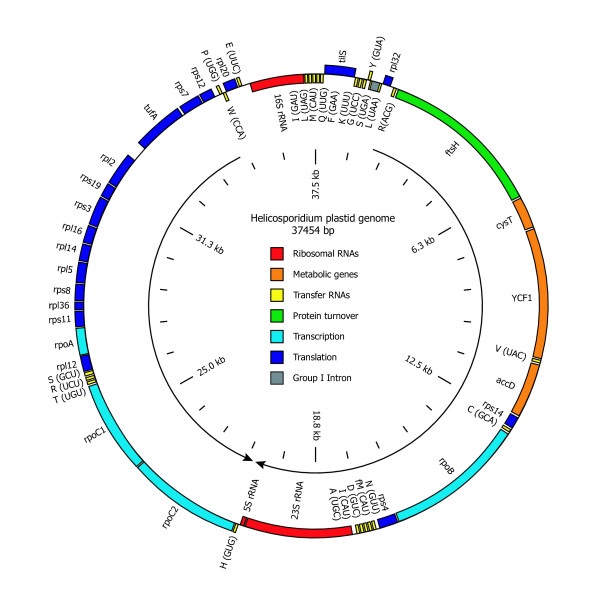
Gene map of Helicosporidium plastid DNA. Genes on the inside of the map are transcribed clockwise, while those on the outside are transcribed counter-clockwise. Transfer RNAs are indicated by the one-letter amino acid code followed by the anticodon in parentheses. rRNA: ribosomal RNA subunits, rpo: RNA polymerase subunits, tufA: elongation factor Tu, tilS: tRNA(Ile)-lysidine synthetase, ftsH: ftsH protease, cysT: sulfate transport protein, ycf1: conserved plastid protein of unknown function, accD: acetyl-CoA carboxylase beta subunit.